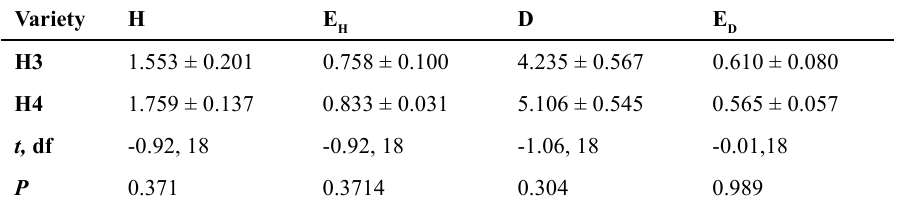
Table 3 . Means (± SE) of Shannon diversity index (H), Shannon’s equitability (EH), Simpson’s diversity index (D), and Simpson’s equitability (ED) for pollinator diversity recorded on sunflower